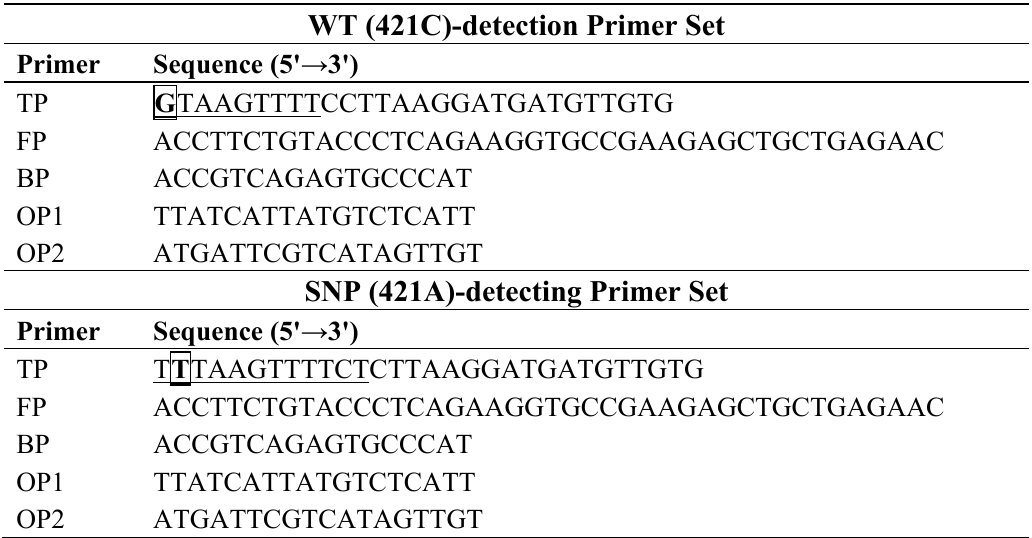
Table 1. Primer sets to detect WT and SNP alleles in the human ABCG2